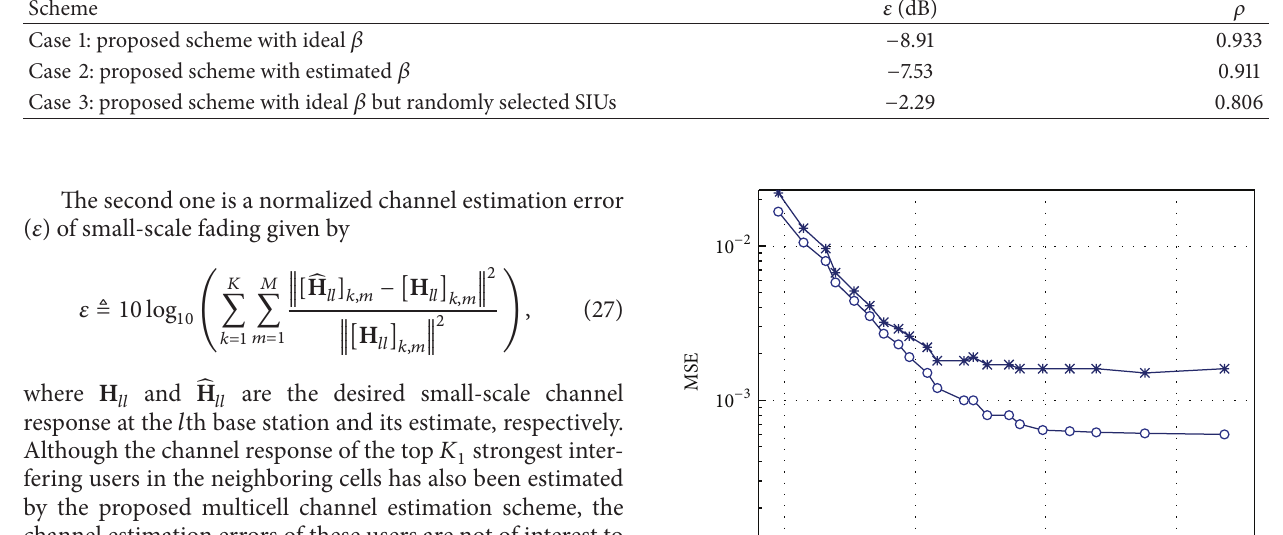
Table 2: Impact of large-scale fading estimation and SIU selection on the performance of small-scale fading estimation. Scheme